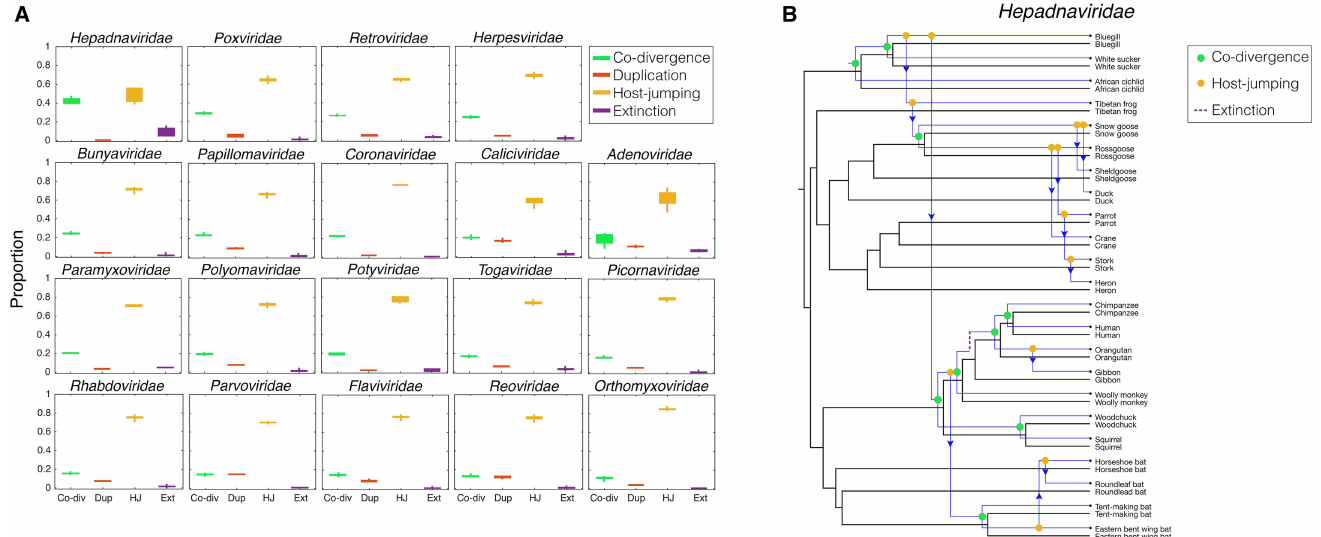
Fig 5. (A) Reconciliation analysisof each virus family using Jane [15]. Boxplots illustrate the range of the proportionof possibleevents. The ‘event costs’ associatedwith incongruencesbetweentrees were conservativetowards co-divergence and definedhere as: 0 for co-divergence, 1 for duplication, 1 for host-jumpingand 1 for extinction. Virus families are rankedin order of highest mean co-divergence to lowest mean co-divergence. Abbreviations on the x-axis are as follows: ‘Co-div’ = co-divergence, ‘Dup’= duplication, ‘HJ’ = host-jumping, ‘Ext’ = extinction. (B) Reconciliation of the Hepadnaviridae phylogenywith that of their vertebrate hosts, again utilizingthe co-phylogenetic method implemented in Jane [15]. The figure illustrates all possibleco- divergence,extinctionand host-jumpingevents (no lineageduplication events were reconstructed in this case).